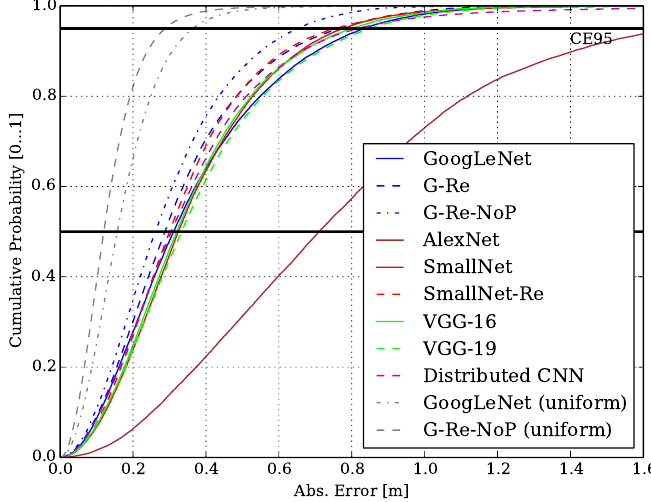
Figure 11. Cumulative Probability over the Meander dataset